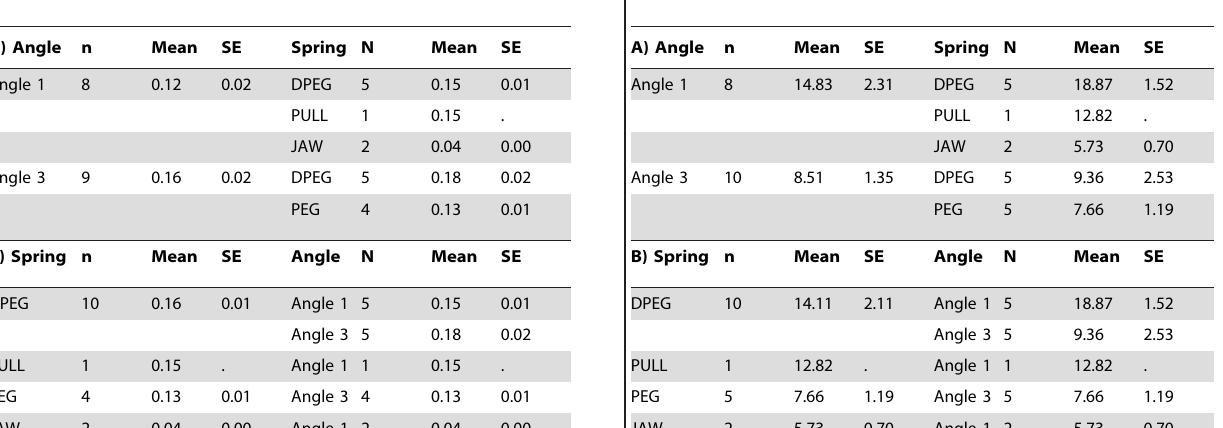
Figure 2. Raw data for impact momentum against clamping force in mouse and rat trap replicated sets. A) mouse trap types; B) rat trap types. Each point represents an individual trap and traps of the same type are enclosed within a polygon. These trap types are identified on Figure 1. For scale, the small square, demarcated by the dotted lines and the axes on Figure 2B, represents the entire range of clamping forces and impact momentums shown by Figure 2A.